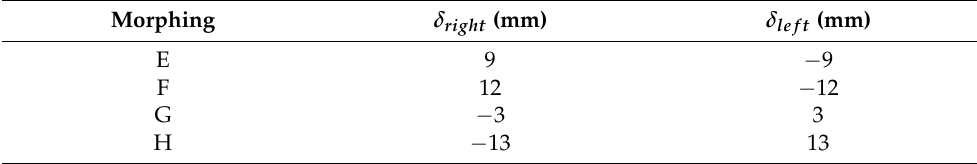
Table 5. Actual deflections of the wing during twisting due to arbitrary morphing E to